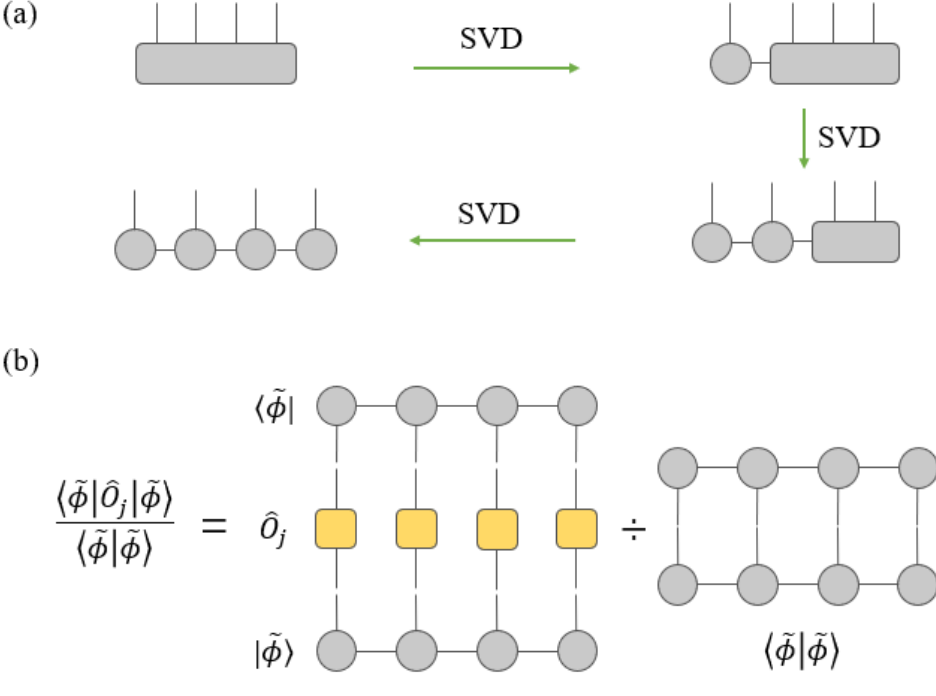
Figure 1. ( a ) Decomposition of a four-qubit quantum state into a matrix product state using a series of singular value decompositions. ( b ) Evaluating the expectation value of a Pauli string ˆ O j on the variational MPS ansatz | ˜ φ (cid:105)